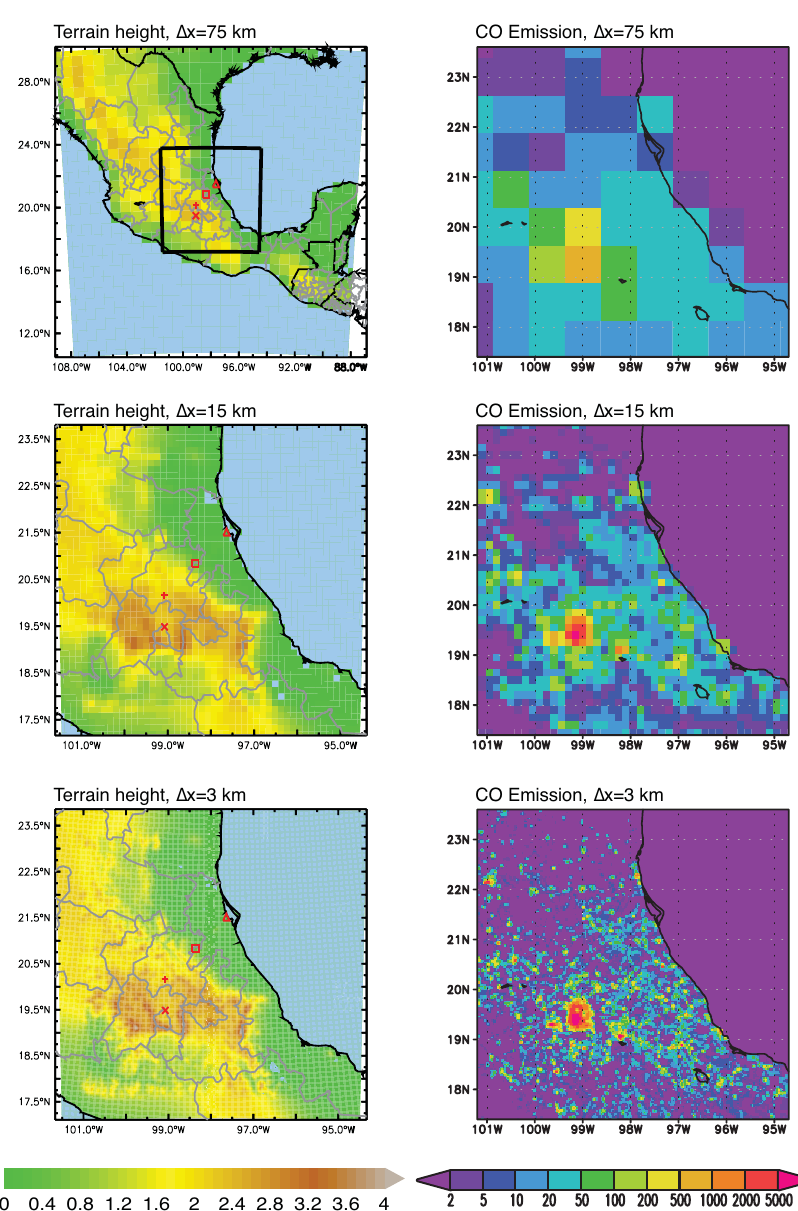
Fig. 2. Model domain and terrain (left column, unit: km) and spatial distribution of surface carbon monoxide emissions (right column, unit: